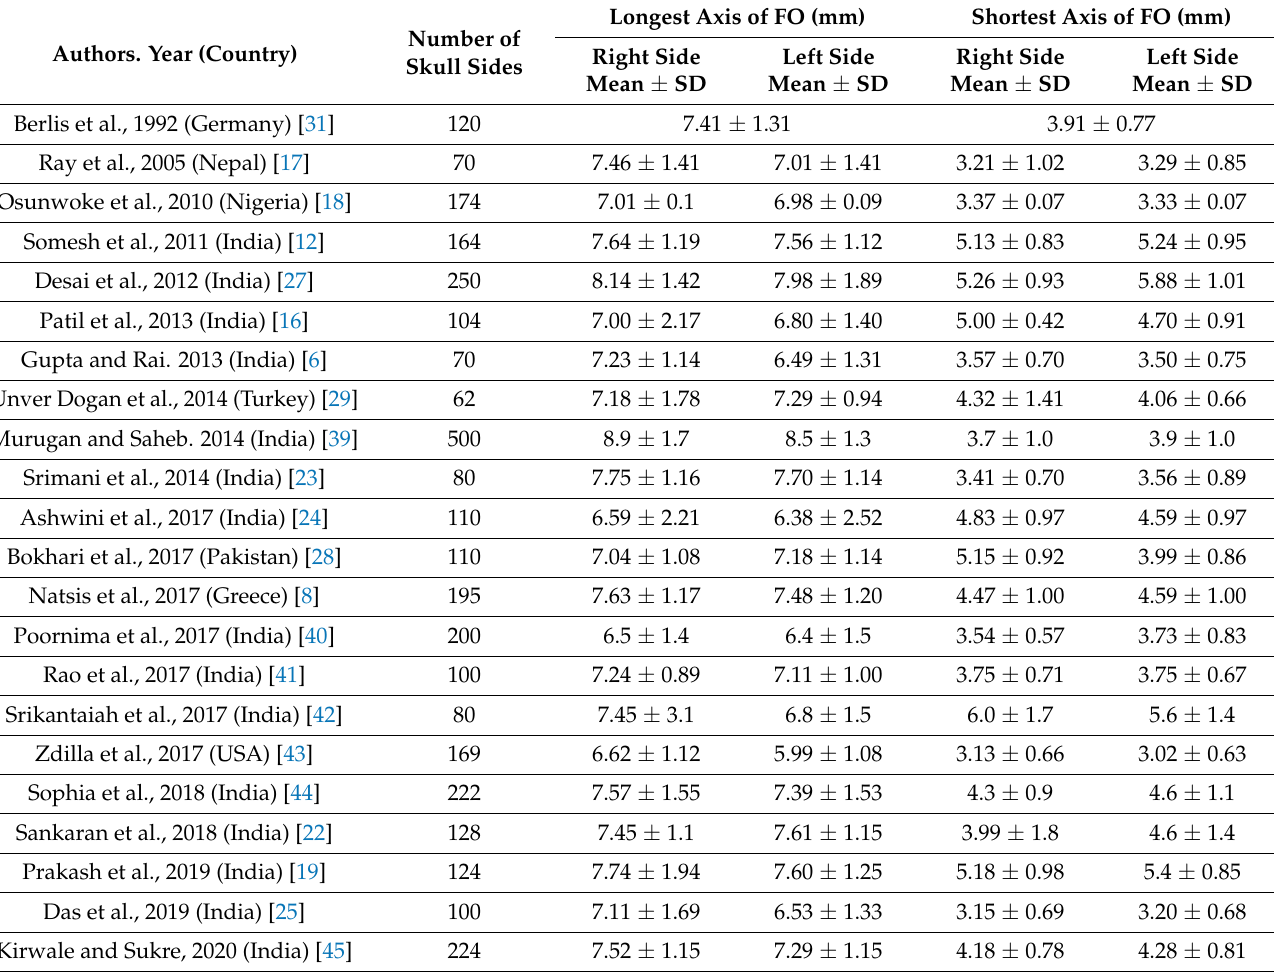
Table 3. Comparison of FO dimensions between the present and previous